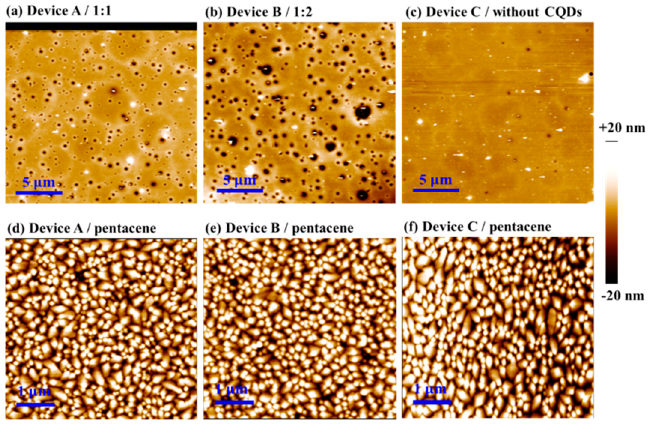
Figure 3. Atomic force microscopy (AFM) images of different CQDs/PVP hybrid nanolayers. The CQD–ethanol saturated solution and anhydrous ethanol were mixed in volume ratios of ( a ) 1:1 (device A), ( b ) 1:2 (device B), and ( c ) without CQDs in PVP (device C). ( d )–( f ) AFM images of pentacene deposited on the corresponding CQDs/PVP hybrid nanolayers.